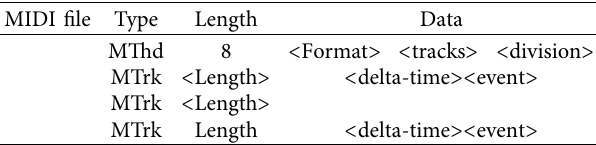
Table 1: MIDI file format. MIDI file